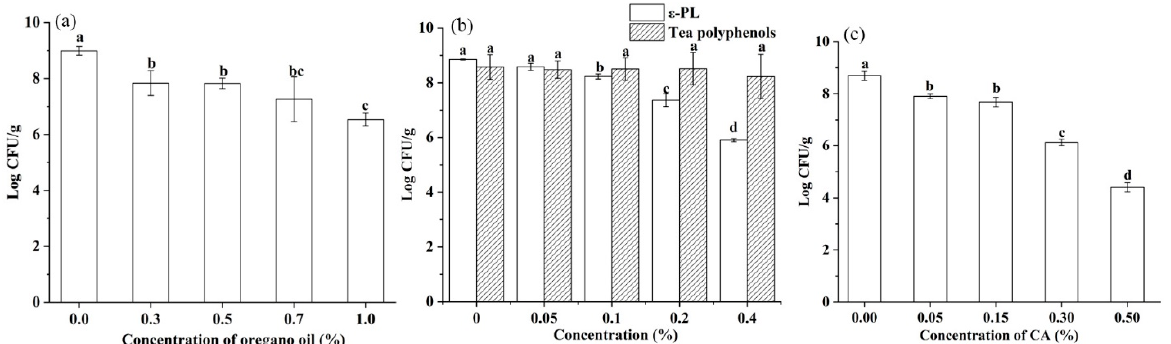
Figure 6. Synergistic antibacterial effects of heating (56 °C for 8 min) and antimicrobials (( a ): oregano oil, ( b ): ε -PL and tea polyphenol, ( c ): CA) against S. montevideo CICC 21588 in diluted tahini at different concentrations. The same low case letter among different concentration treated samples indicates values are not significantly different ( p > 0.05).